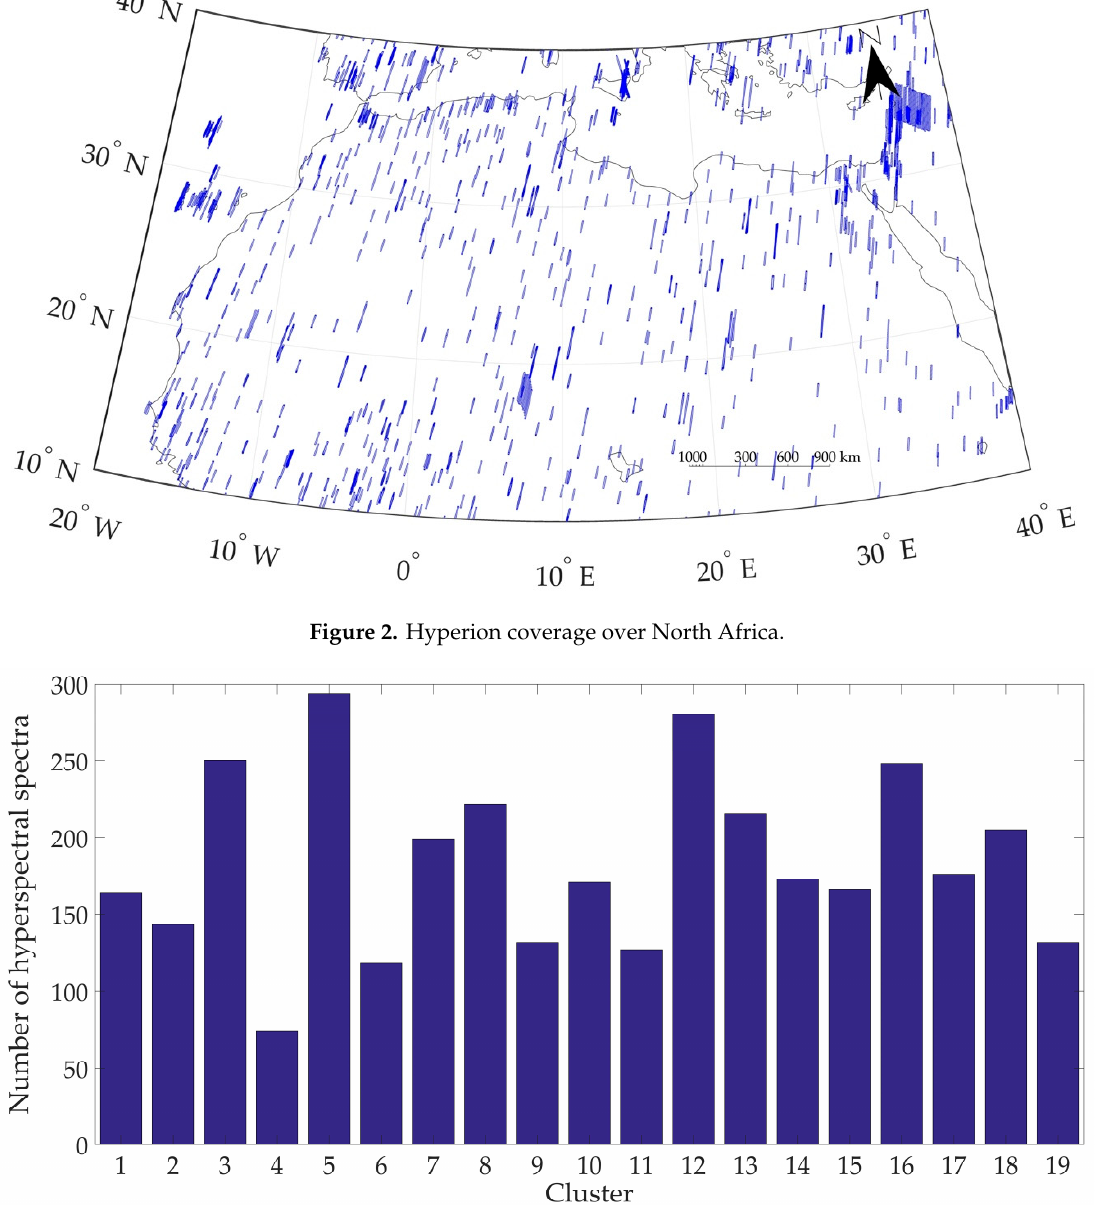
Figure 3. Number of hyperspectral spectra over different North African clusters.